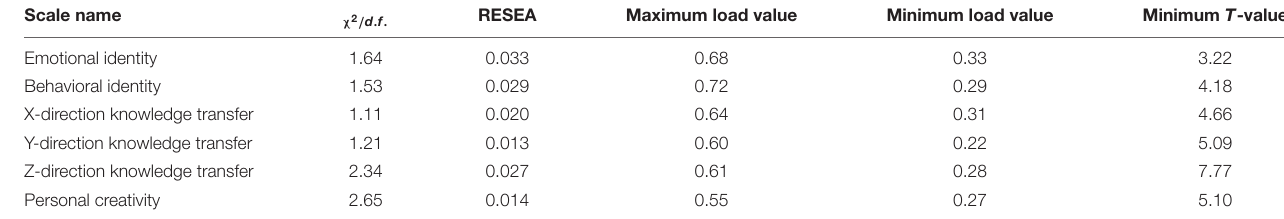
TABLE 3 | Validity test results.